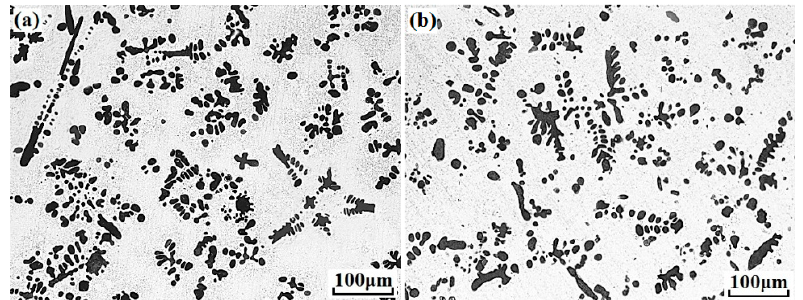
Figure 1. Microstructures of alloys with normal solidification: ( a ) Cu–14Fe; ( b ) Cu–14Fe–0.1Ag.